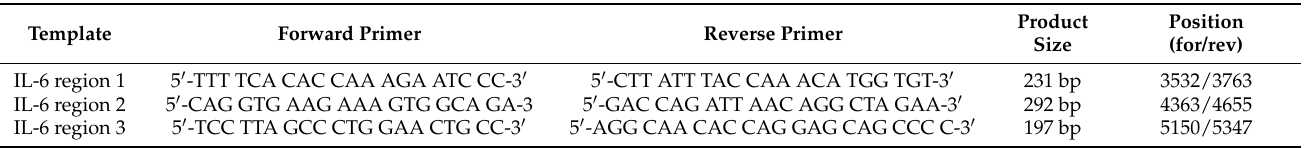
Table 2. Sequences, PCR product sizes and position within the IL-6 gene of the primer pairs used in the ChIP-RT-qPCR assays. The information on the primer positions refers to the NCBI reference sequence for human interleukin 6: NG_011640.1.